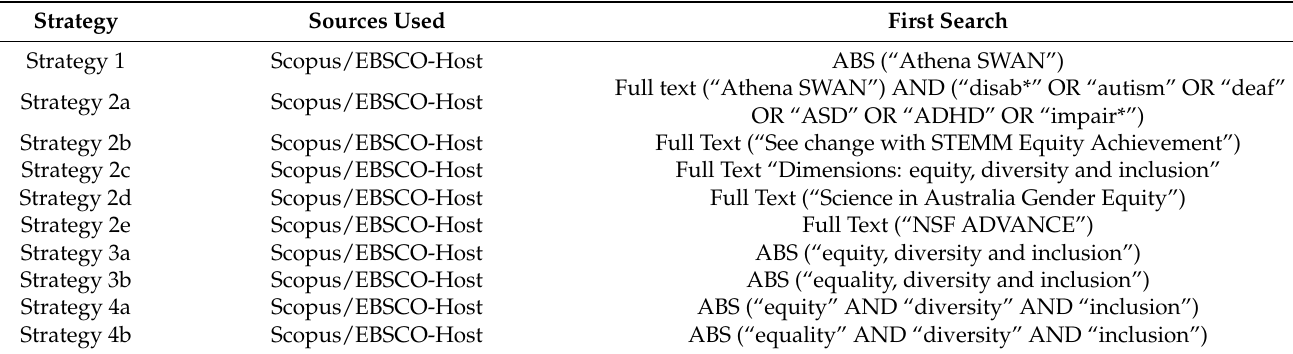
Table 1. Search Strategy